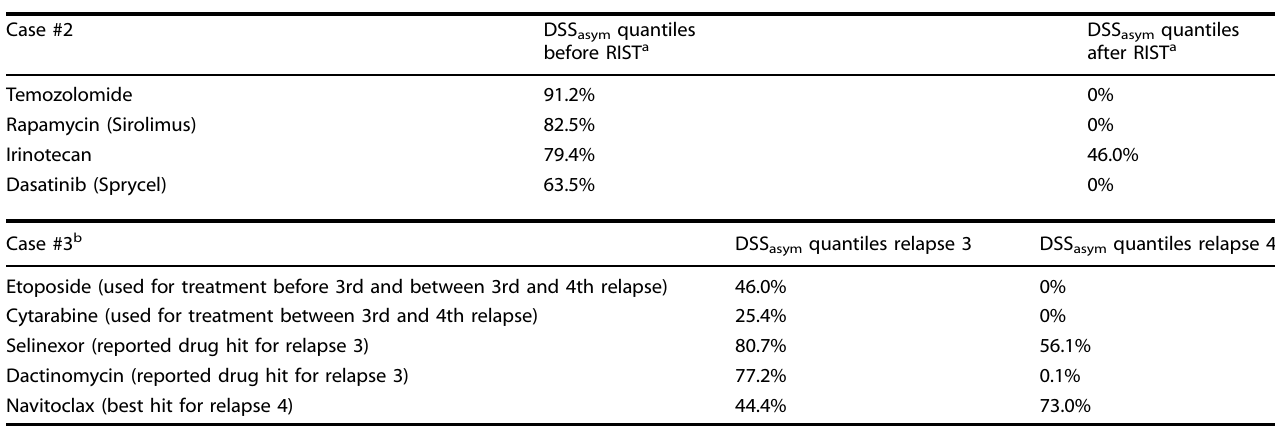
Table 2. Drug response details for cases #2 (EWS) and #3